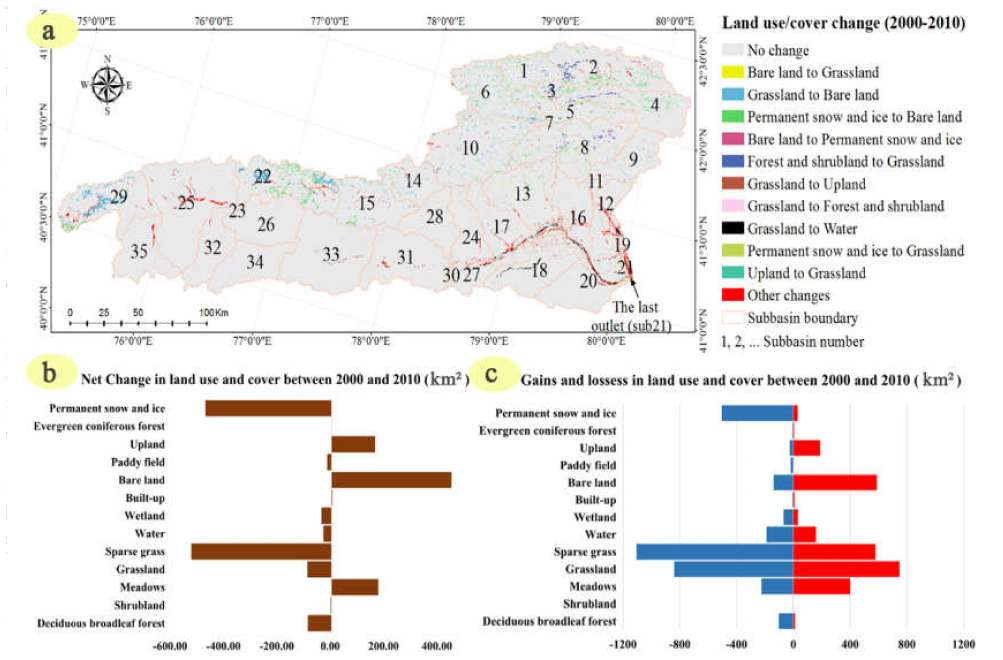
Figure 2. Historical land use/cover change in the Aksu River Basin from 2000 to 2010: ( a ) change in the spatial pattern of land use and land cover; ( b ) net variation in the quantity of land use/cover type; and ( c ) gains and losses of land use/cover